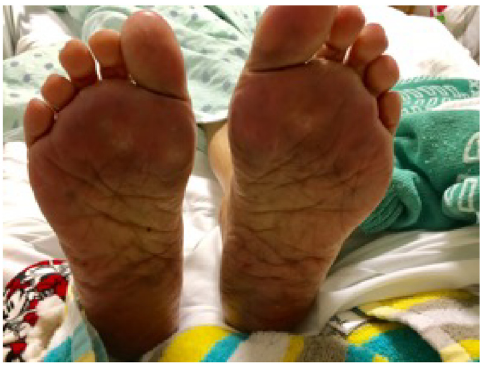
Figure 2. Erythema, swelling, and desquamation of the plantar